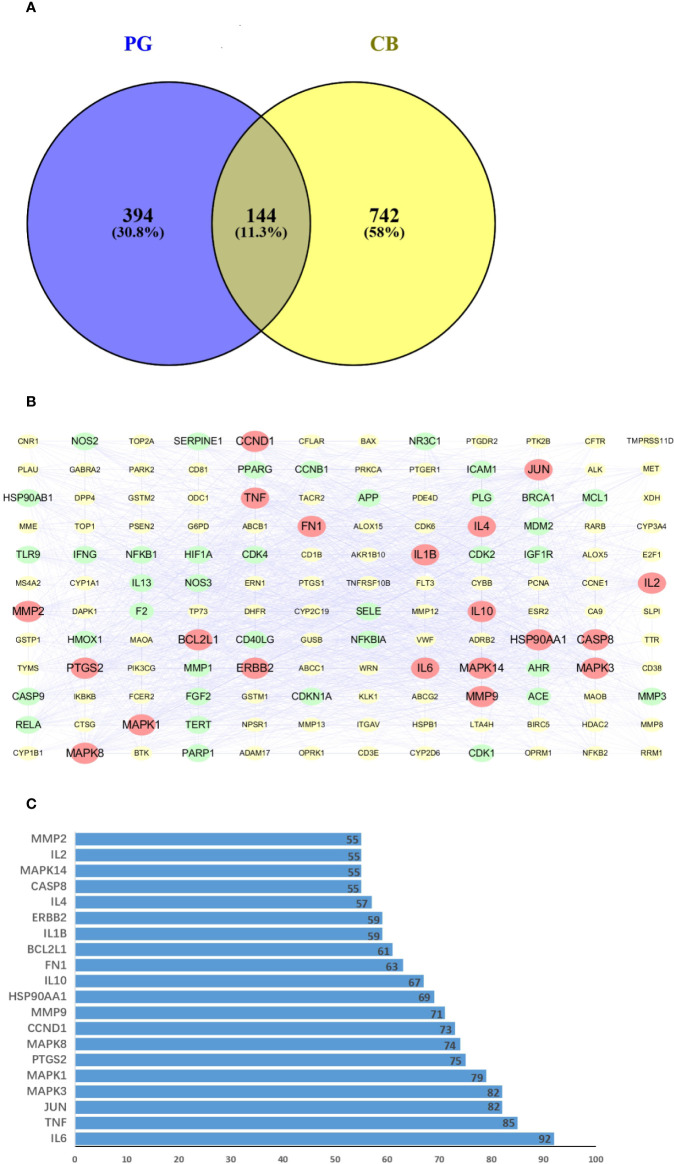

(A) Venn diagram of related targets of Platycodon grandiflorum (PG) and chronic bronchitis (CB). (B) Protein-protein interaction (PPI) network of overlapping targets between drug and disease, the yellow boxes represent the nonpotential target, the green boxes represent the potential target, and the red boxes represent the core target. (C) Number of adjacent nodes of overlapping targets between drug and disease, the X-axis indicates the number of neighboring proteins of the target, the Y-axis indicates different targets.